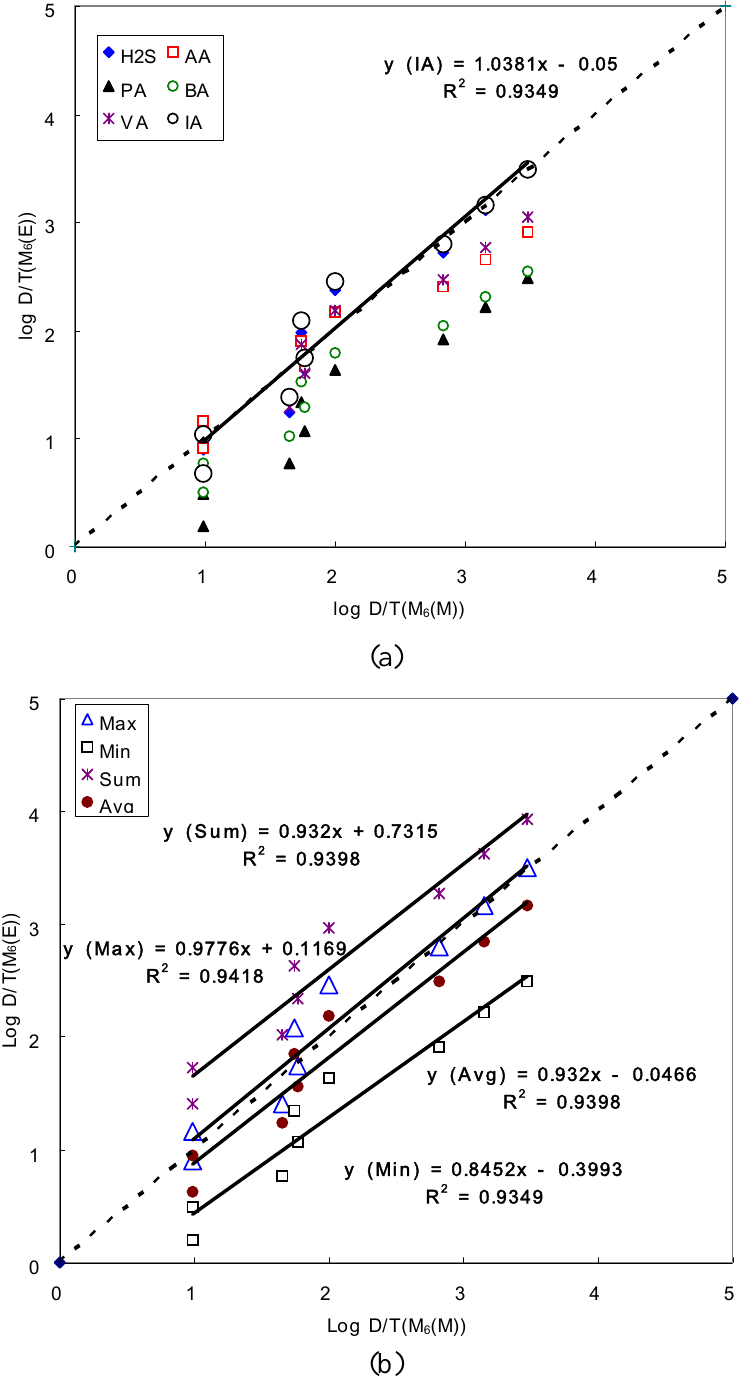
Figure 4. Comparison of the D/T ratios for M estimated values with various combinations (D/T(M (b) artificial combinations. Letters of M and E in the parenthesis denote measured and estimated, respectively.